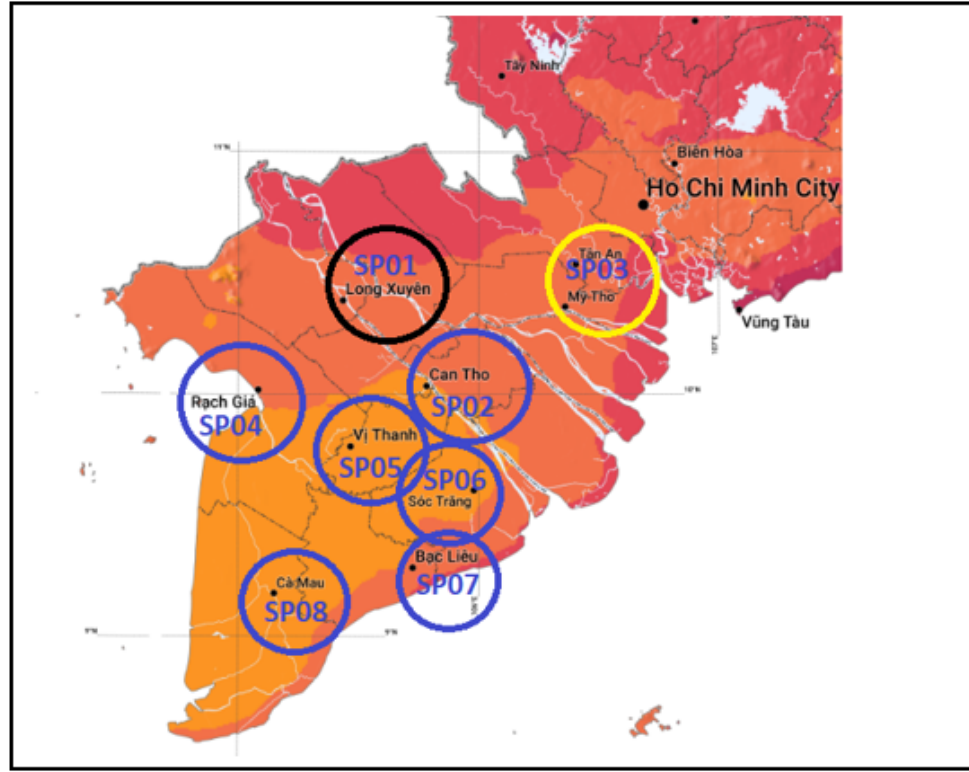
Figure 3. Potential locations in Mekong Delta, Vietnam for solar power plant setup. Table 1. Eight potential locations for solar power plant investment.